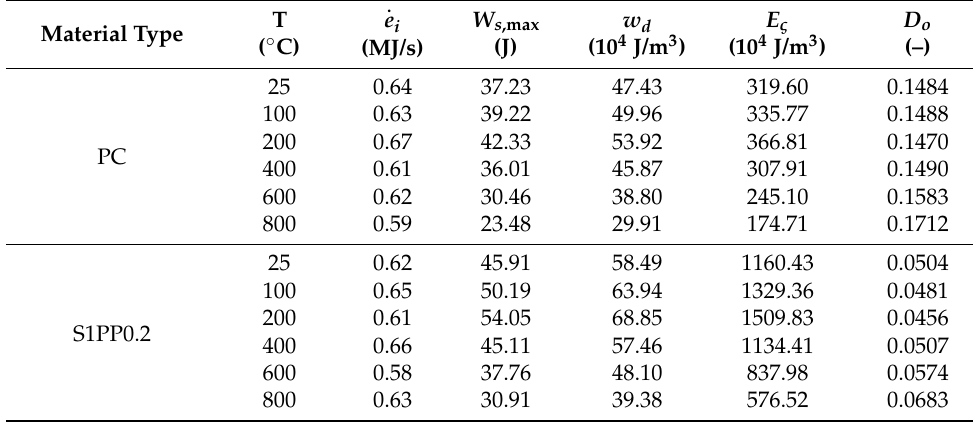
Table 5. Changes of damage variables at different